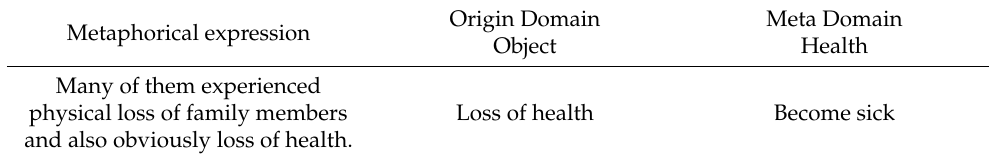
Table 14. Health is an Object. Metaphorical